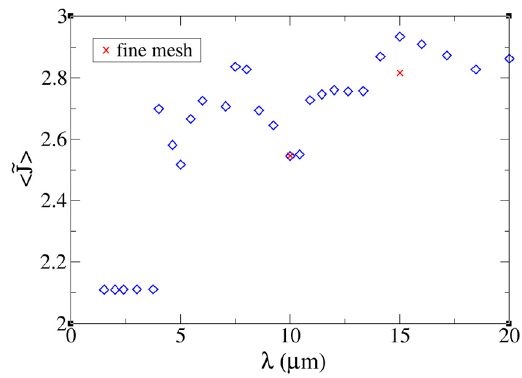
Figure 17. Baseline 2-D case, (cid:101) V = 20 (transition from limiting to overlimiting regime). Time- and area-averaged current density.